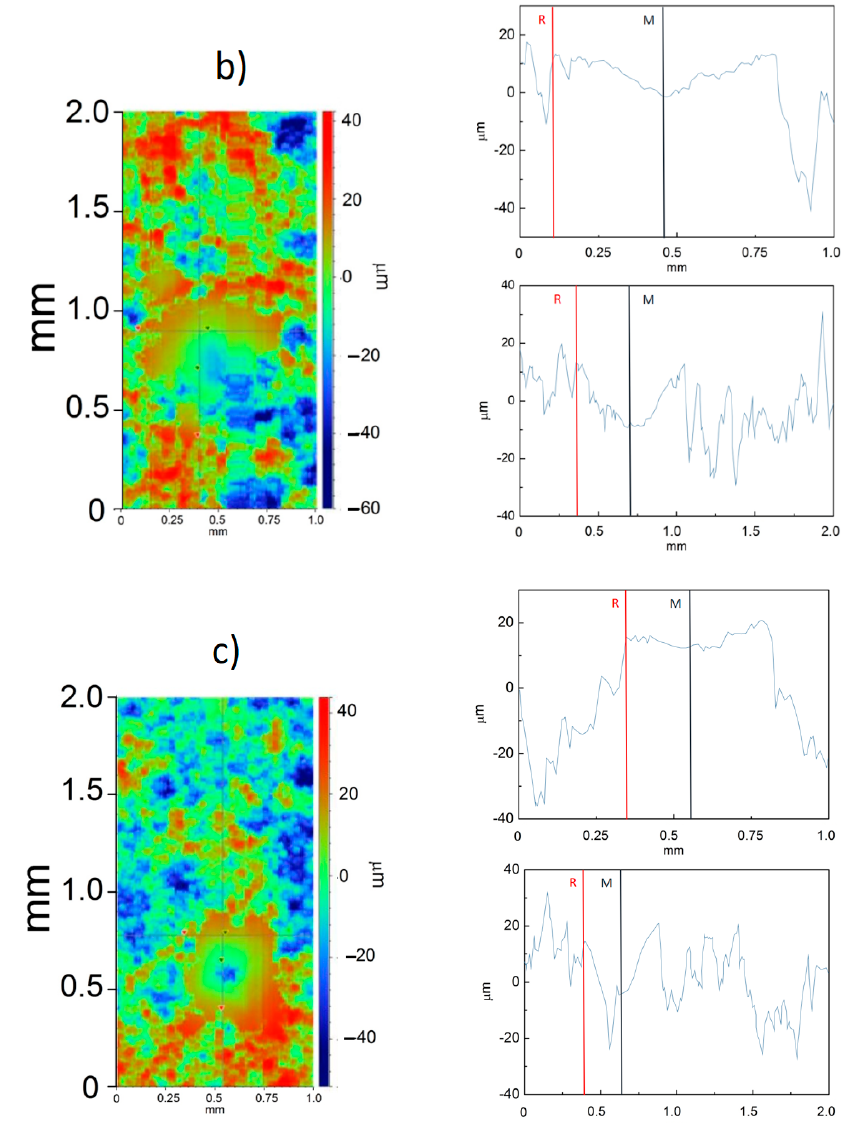
Figure 9. Rails profiles for the wear at the loads of 50 N ( a ), 100 N ( b ) and 150 N ( c ). The wear volume was measured at the end of each test at various loads. As a conse- quence of the micro wear processes in action, the volume loss is very low. It is calculated from the automatic revealing of the profiles during each test. The corresponding weight loss as a function of the load is shown in Figure 10.